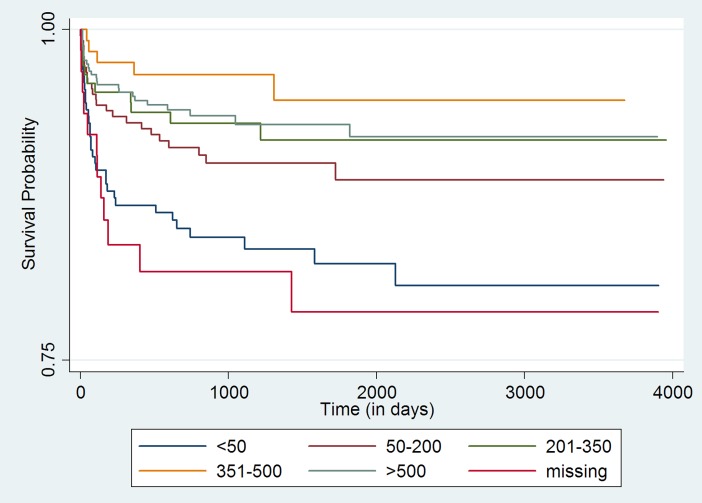
Unadjusted Kaplan-Meier survival curves for treatment outcome of HIV positive children who receiving ART in Mingalardon Specialist Hospital by CD4 count (2006 to 2016).Log rank test chi2 p-value: 0.0001.